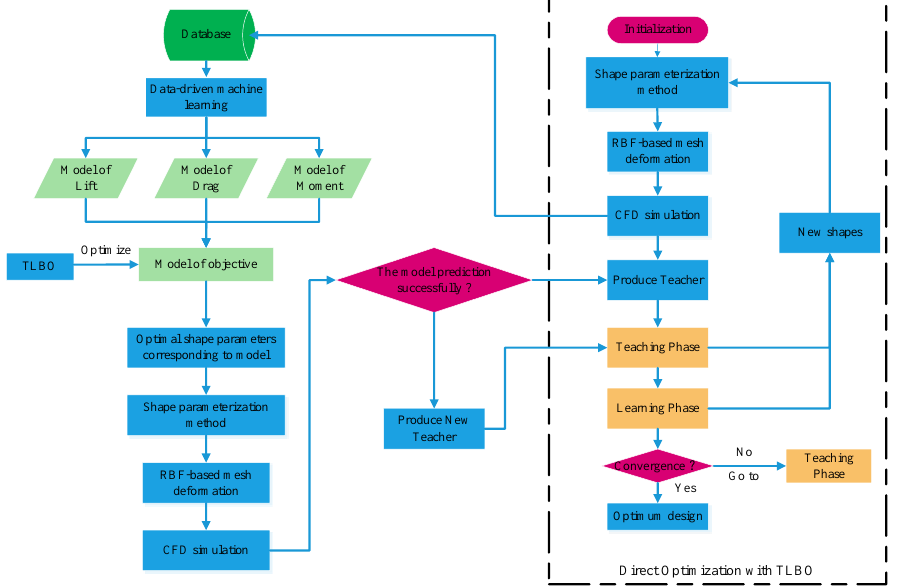
Figure 2. Flowchart of the data-driven surrogate-assisted optimization framework for aerodynamic design.